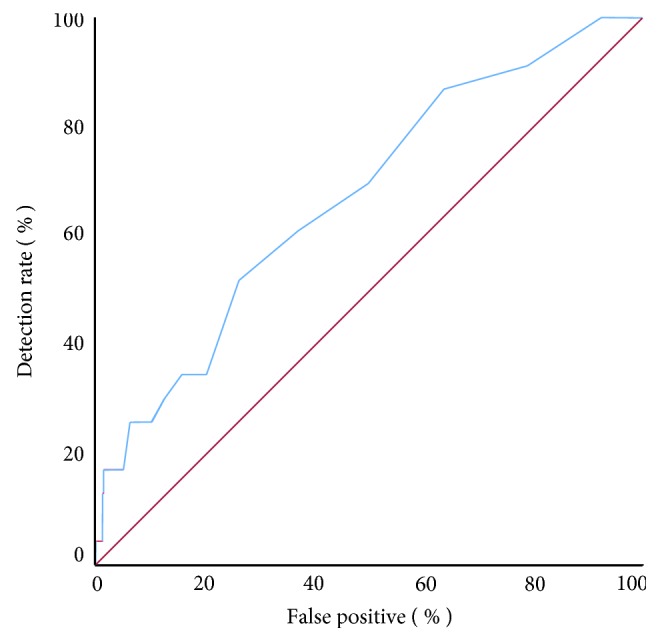
Receiver operating characteristics (ROC) curve for the prediction of premature birth before 34 weeks of gestation in the studied population.